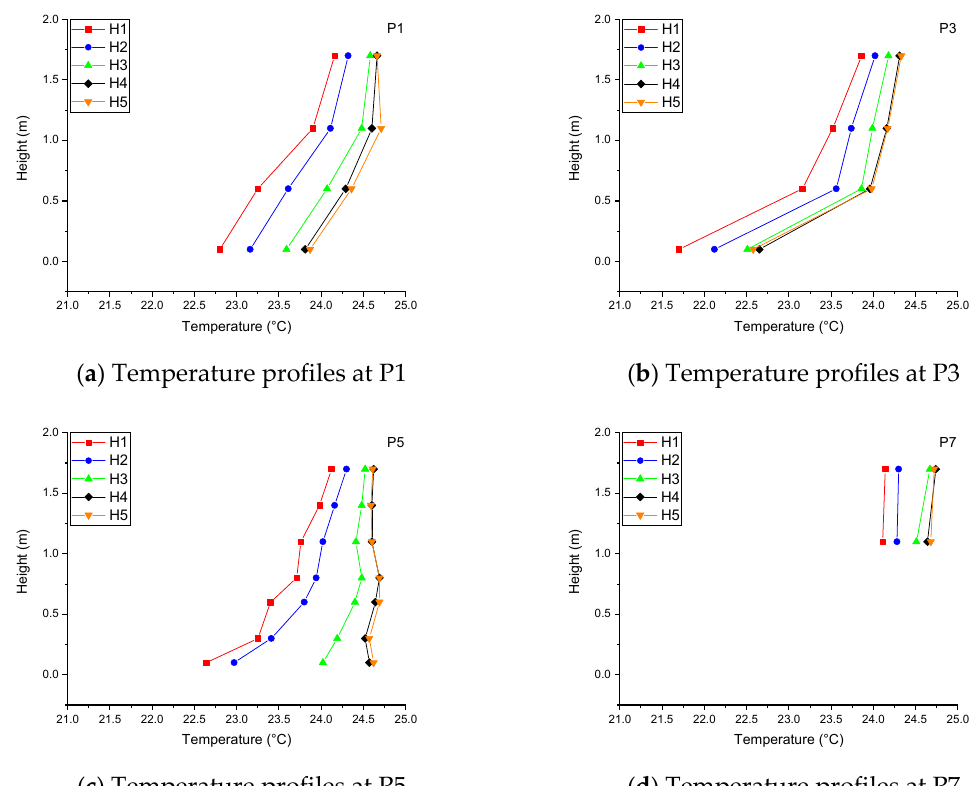
Figure 5. Air temperature profiles at position P1 ( a ), P3 ( b ), P5 ( c ) and P7 ( d ) for heating cases (H1–H5).